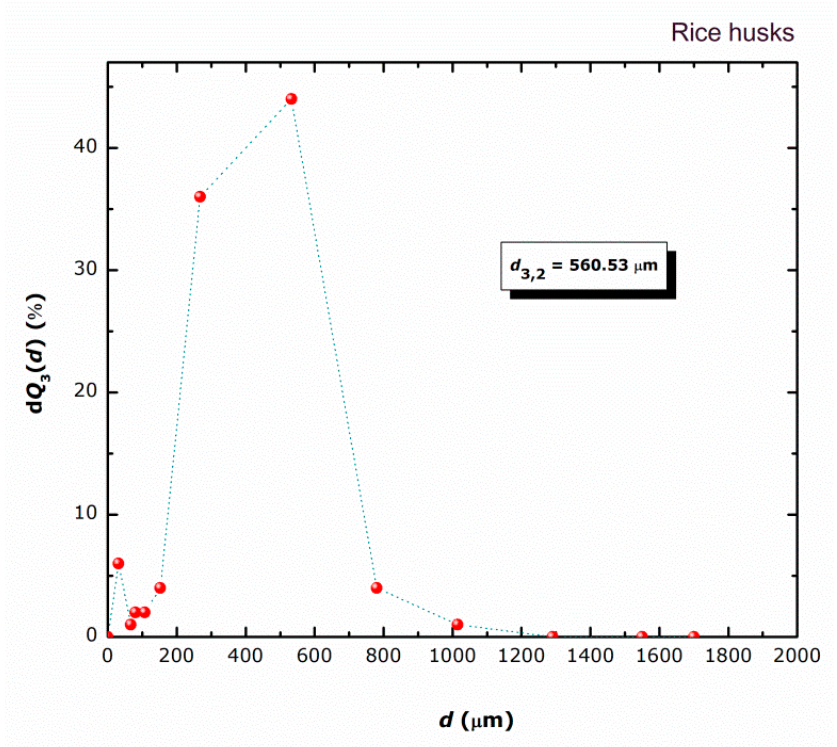
Figure 4. Size distribution data for RH particles.